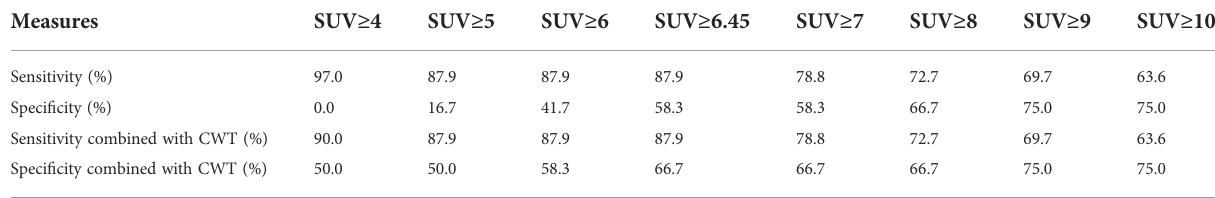
TABLE 4 Sensitivity and speci fi city of SUVmax and SUVmax combined with localized CWT in the identi fi cation of high-risk lesions from incidental focal colorectal 18 F-FDG uptake foci.